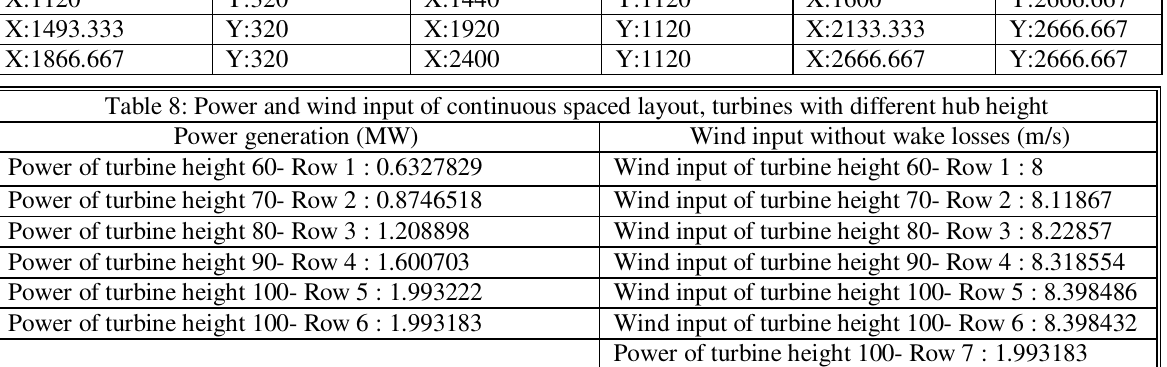
Table 8: Power and wind input of continuous spaced layout, turbines with different hub height Power generation (MW) Power of turbine height 60- Row 1 :